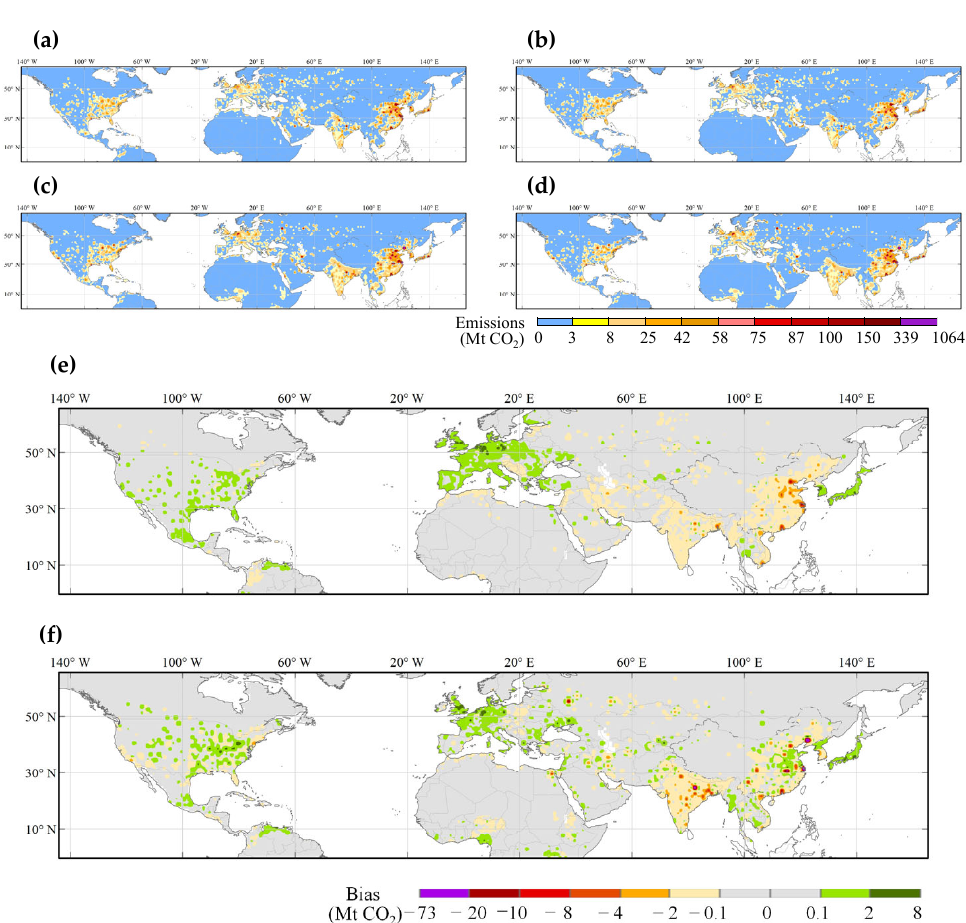
Figure A4. Averages of monthly inventories and predicted emissions based on the GRNN using satellite observations in 2019 for ( a ) original ODIAC, ( b ) predicted emissions for ODIAC, ( c ) original EDGAR, ( d ) predicted emissions for EDGAR, ( e ) bias for ODIAC, and ( f ) bias for EDGAR.